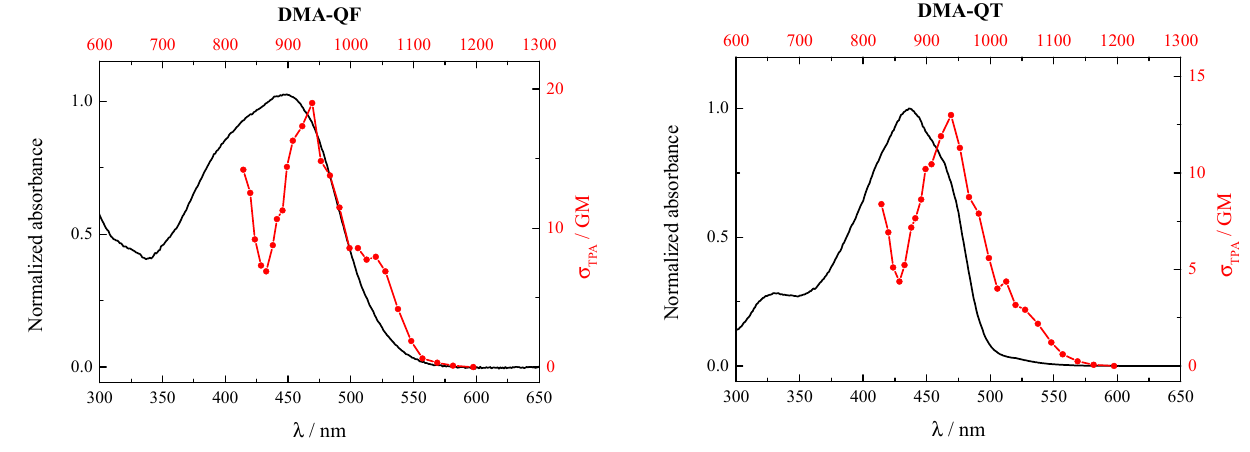
Figure 5. Comparison between TPE (two-photon excitation, red) and OPE (one-photon excitation,